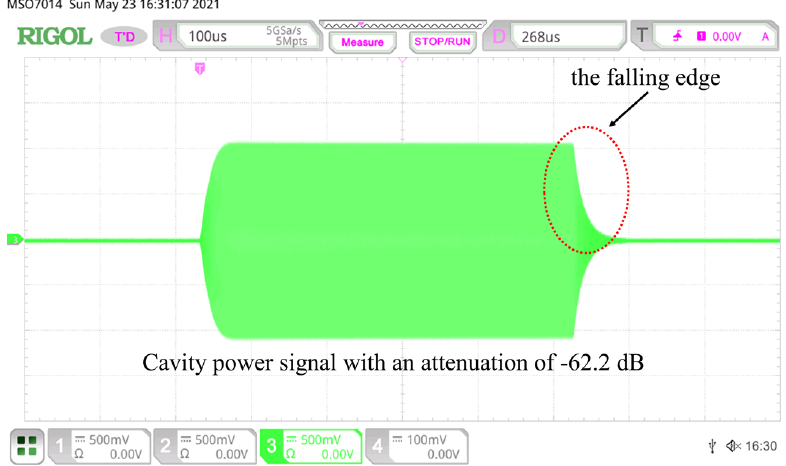
Figure 13. Pickup signal of the RFQ cavity.